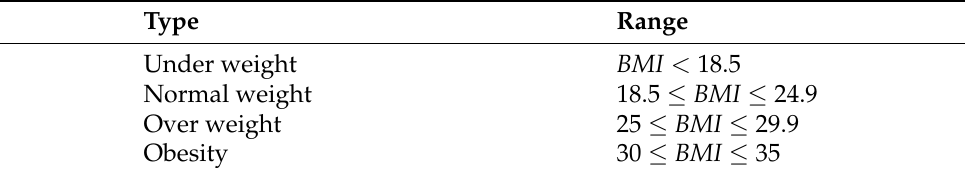
Table 4. Body mass index